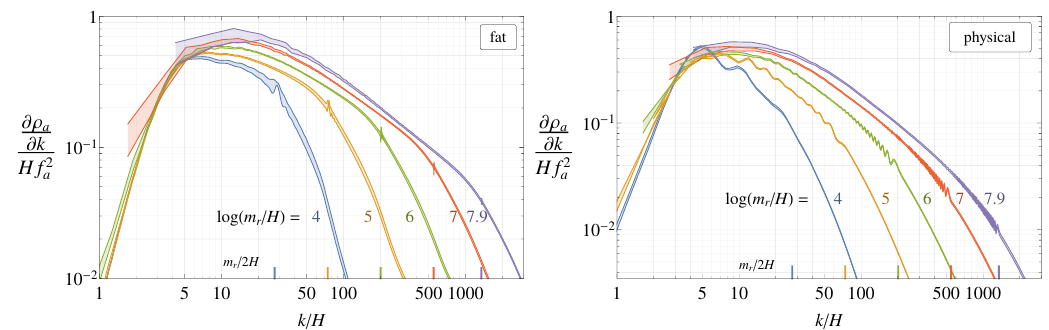
Figure 12: The axion energy density spectrum at different times (i.e. at different / H ) ) for the fat (left) and physical (right) string systems, as a func- value of log ( m r tion of the momentum k in units of Hubble. In both cases the spectrum is dominated by a broad peak at around k / H = 10, and emission at lower momenta is suppressed. / 2, corresponding to the para- For each time shot we also show the value of k = m r metric resonance frequency with the radial mode. There is little energy in modes with momenta corresponding to scales smaller than the string cores. The physical ∆ = 1 at the final time, and the fat simulations have m ∆ = 1 simulations have m r r throughout.